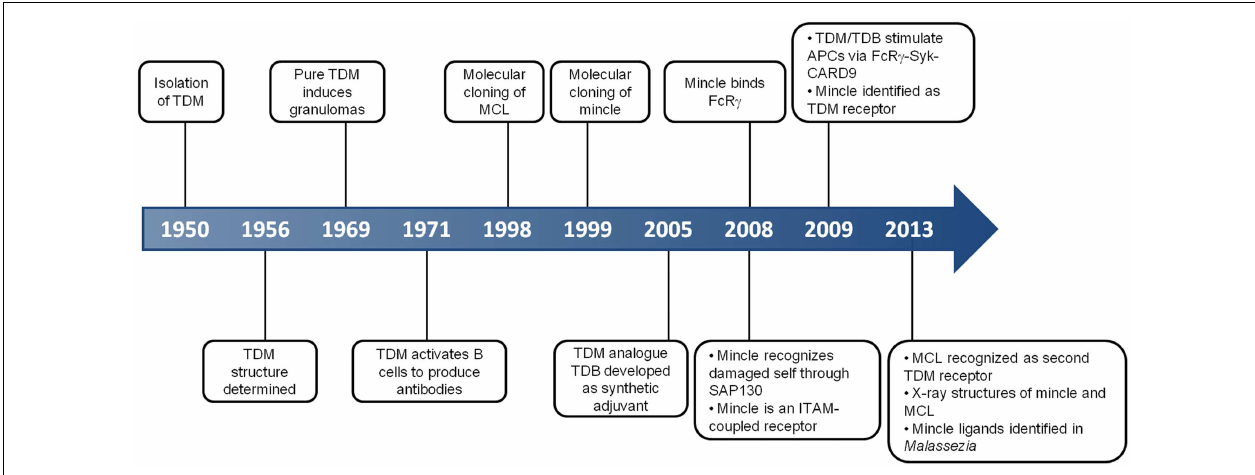
FIGURE 1 | Key events in the history of MCL and Mincle .This timeline depicts some of the critical discoveries that have shaped our understanding of the function and roles of MCL and Mincle.